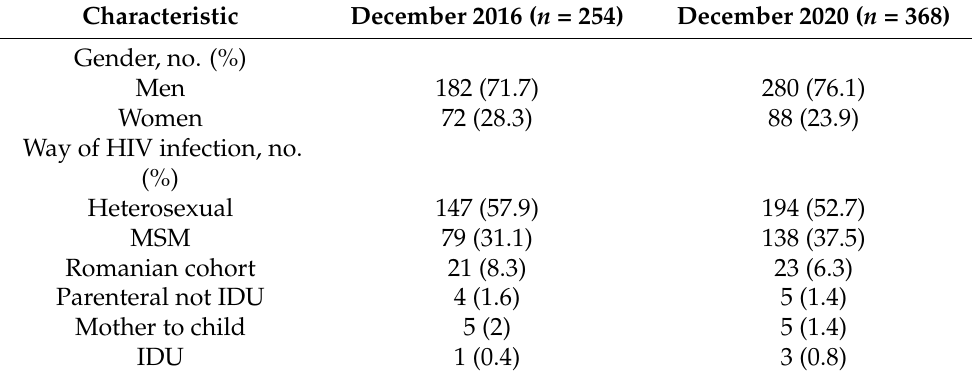
Table 1. Main characteristics of the evaluated patients by